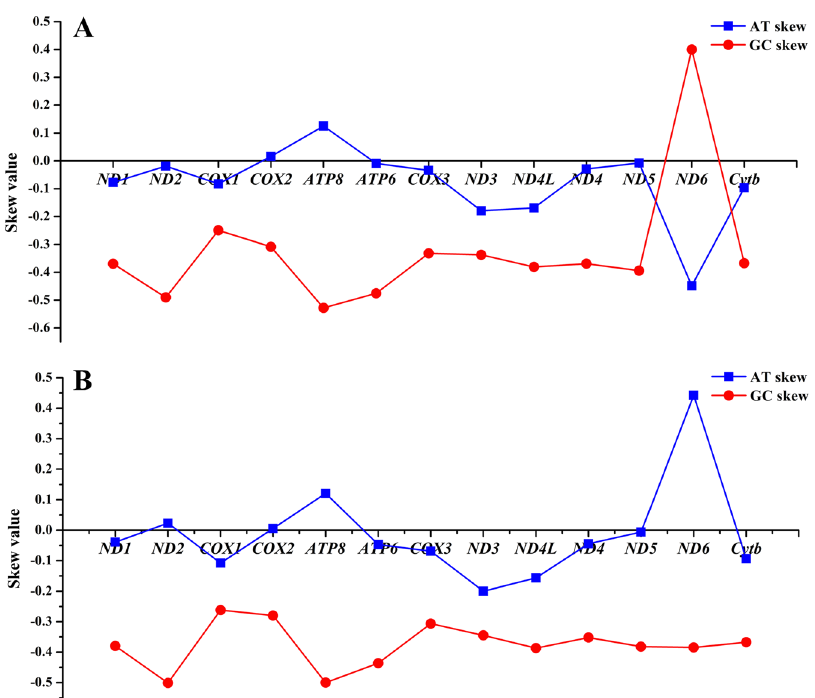
Figure 3. Graphical illustration showing the AT and GC skew in the PCGs of the mitochondrial genome of C. kumu ( A ) and L . microptera ( B